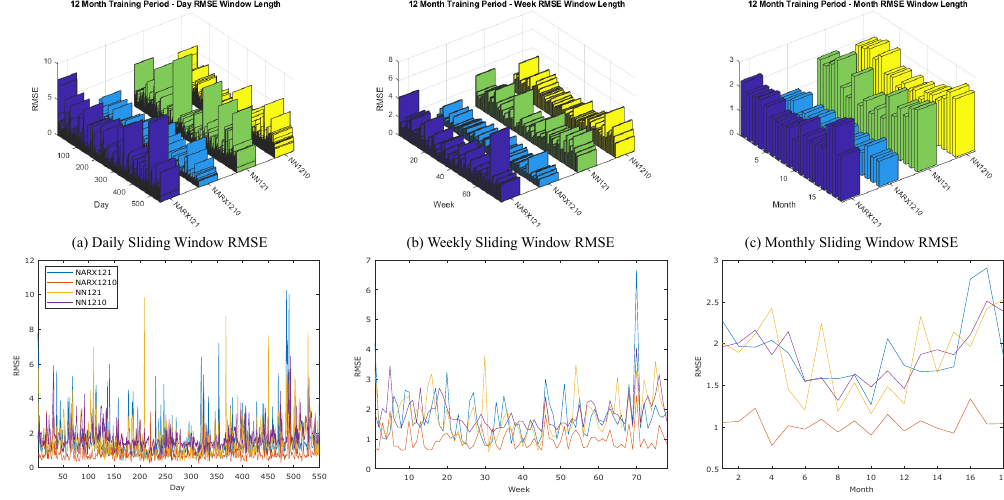
Figure 7. Effect of window length for the